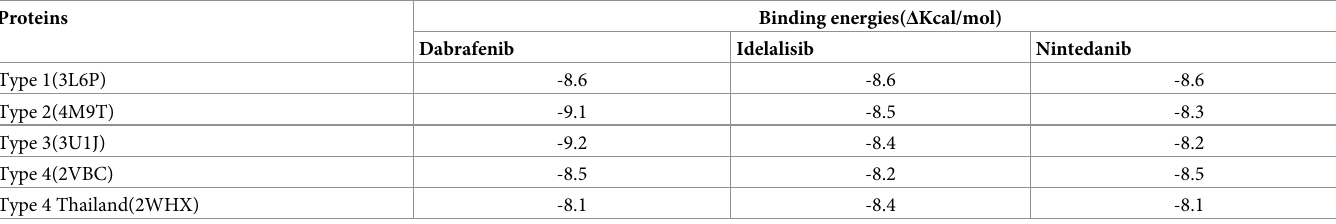
Table 1. Flexible docking binding energies of all serotypes of proteins with ligand molecules.